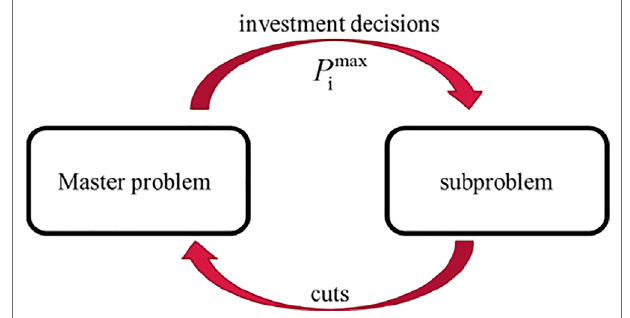
FIGURE 4 | Structure of the distributed algorithm.